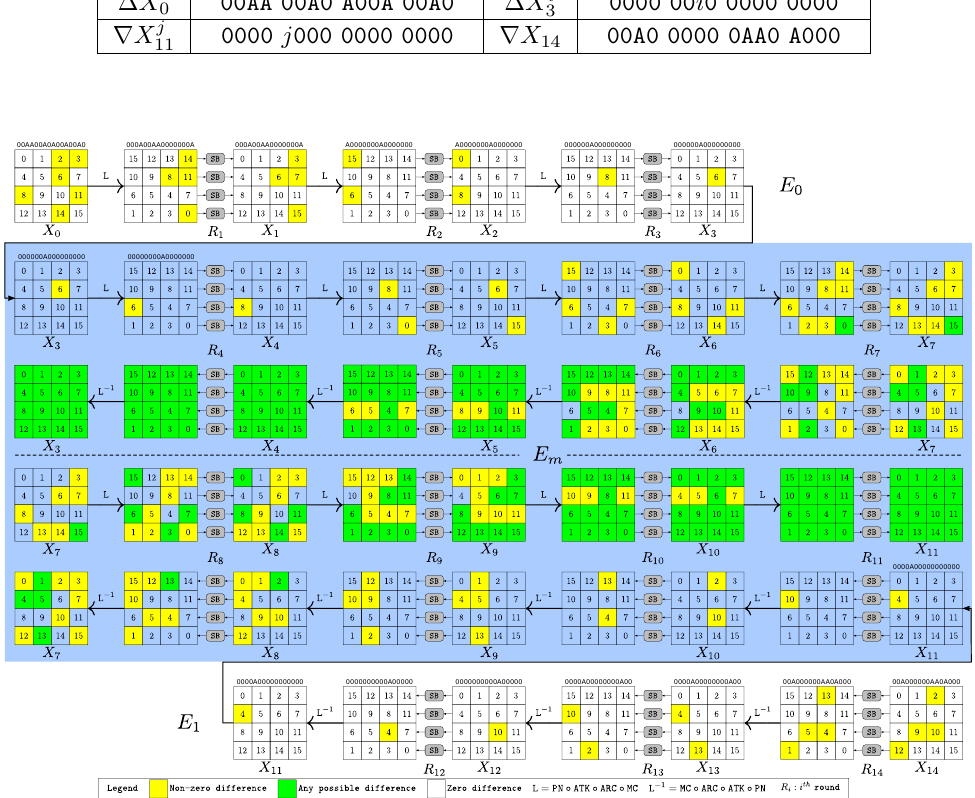
Figure 10: A dedicated boomerang distinguisher for 14 rounds of CRAFT with the form 3 + 8 +